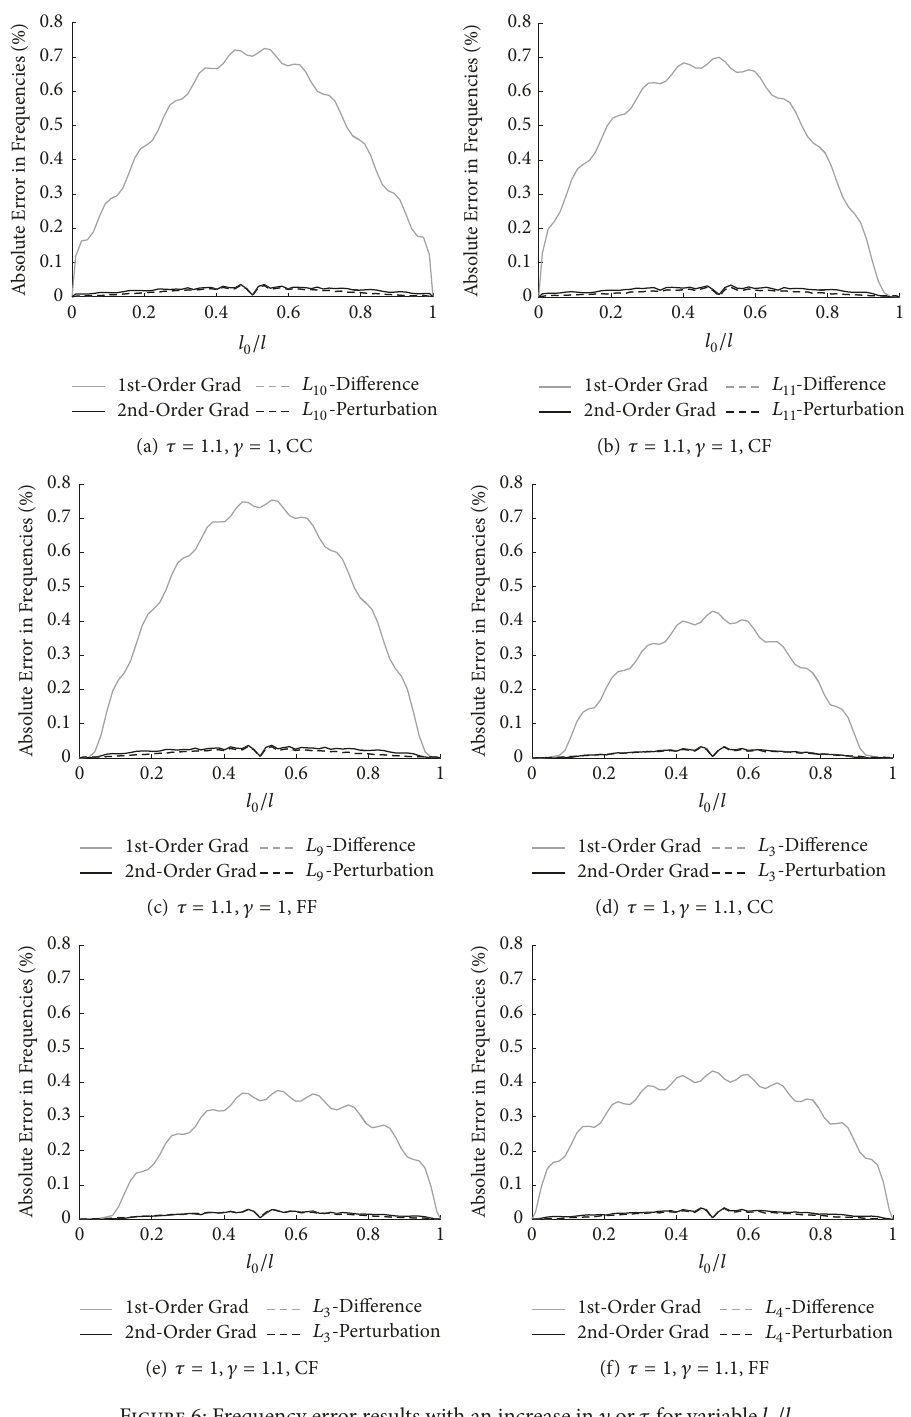
variable parameter are being analyzed. Then, the 𝑝 -value corresponding to the smallest area under the error curves was determined and plotted in the